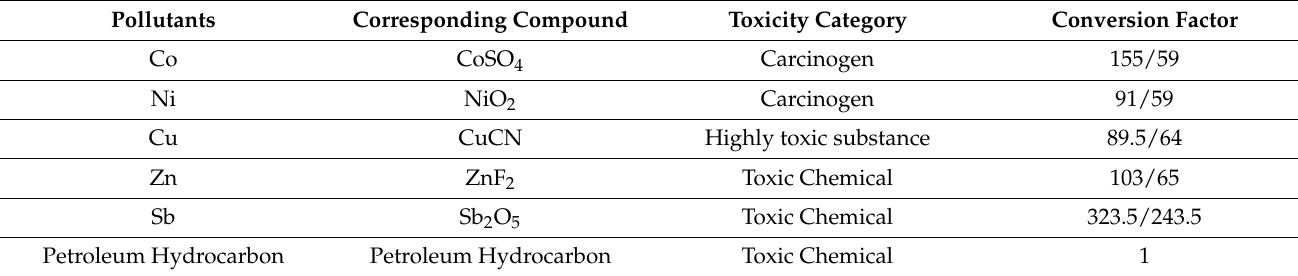
Table 4. Selection of compounds for calculation of inorganic toxic substance content of the spent catalyst. Pollutants Corresponding Compound Toxicity